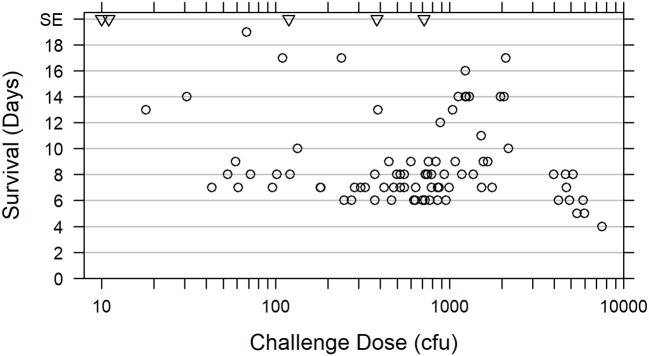
Relationship between survival of cynomolgus macaques and F. tularensis Schu S4 challenge dose. Survival data are presented for 73 cynomolgus macaques challenged with 18 to 7,550 cfu aerosolized F. tularensis Schu S4 in five natural history studies (Studies 1 through 4 and Study 6, Table 1) (open circles). Data for two animals from the pathogenesis progression arm of Study 4 which succumbed prior to scheduled euthanasia are also included. Five animals that survived to the end of the study (SE) after exposure to 10, 11, 119, 382, or 714 cfu in four different studies, are also represented (triangles).